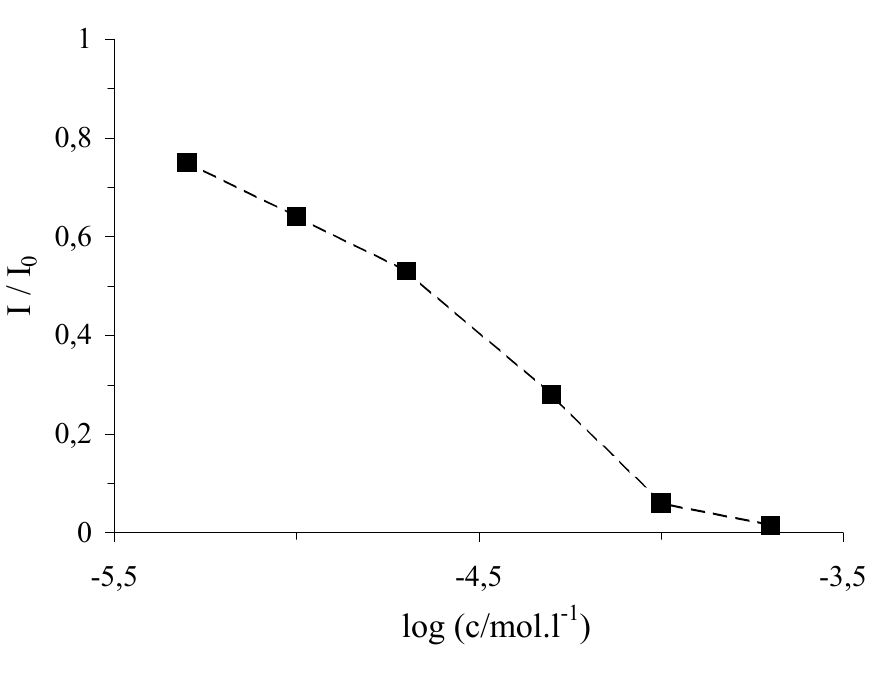
Figure 2. Dependence of the marker relative DPV signal at the DNA/SPE on the concentration of FeSO in the cleavage mixture: FeSO 4 10 mM phosphate buffer pH 7.0, the electrode potential of –0.5 V, incubation for 5 min. Other conditions as in Figure